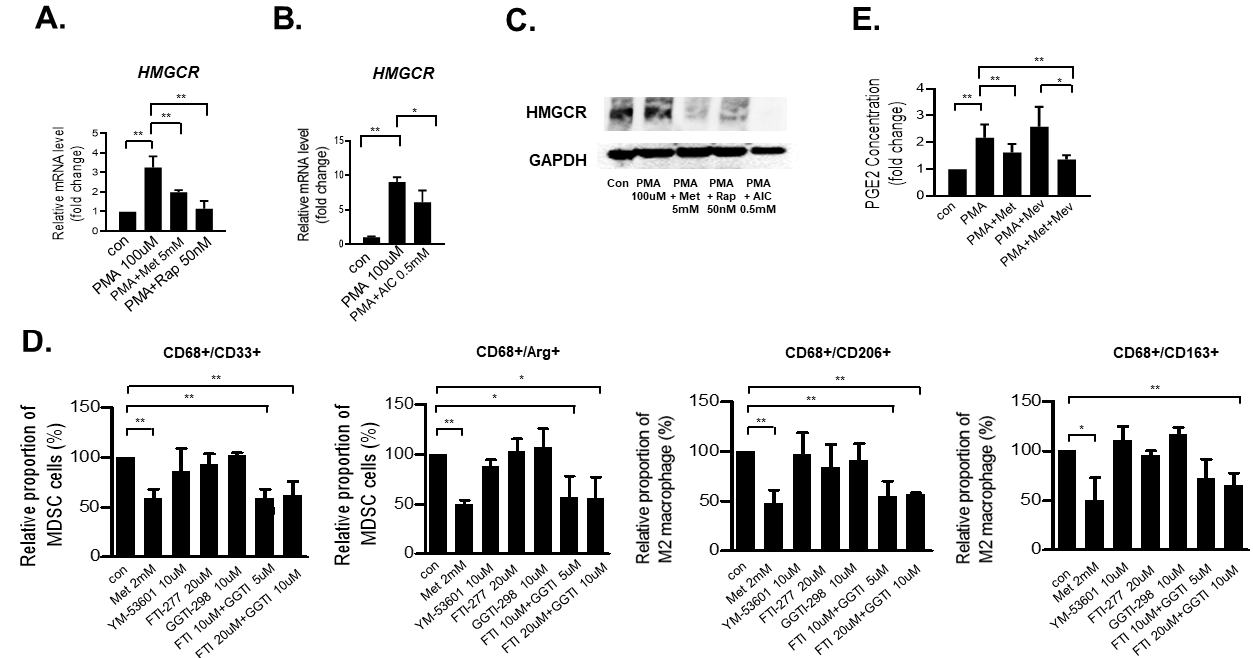
Figure 4. Metformin decreases the fractions of MDSCs and M2 macrophages by downregulating the mevalonate pathway for protein prenylation. ( A ) THP-1 cells were treated with PMA or control vehicle for six hours and then were treated with 5 mM metformin and 50 nM rapamycin for an additional 4 h. ( B ) Regarding the specific condition of the upstream regulator AICAR, THP-1 cells were treated with PMA and AICAR together for 4 h. Cells were harvested and examined by real-time qPCR, normalized to GAPDH expression. Data are expressed as the means ± standard errors of the two different experiments; * p < 0.05, ** p < 0.005. ( C ) In Western blot analysis, the expression of HMGCR was analyzed after 24 h of treatment with the control vehicle or PMA (100 μM) with or without metformin (5 mM), rapamycin (50 nM) and AICAR (0.5 mM) in THP-1 cells. ( D ) THP-1 cells were treated with 2 mM metformin, 10 μM YM - 53601, 10 to 20 μM FTI - 277 and 5 to 10 μM GGTI - 298 for 48 h. Next, the expression levels of MDSC (CD33 + /CD68 + and Arg-1 + /CD68 + ) and M2 macrophage (CD206 + /CD68 + and CD163 + /CD68 + ) markers were analyzed by flow cytometry. Data are expressed as the means ± standard errors of the three different experiments; * p < 0.05, ** p < 0.005. ( E ) THP-1 cells were treated with PMA for 48 h with the control vehicle or co-treated with 2 mM metformin and/or 200 μM mevalonate. After 48 h, the culture supernatant was analyzed by ELISA. Date are expressed as the means ± standard errors of the four different experiments; * p < 0.05, ** p < 0.005.